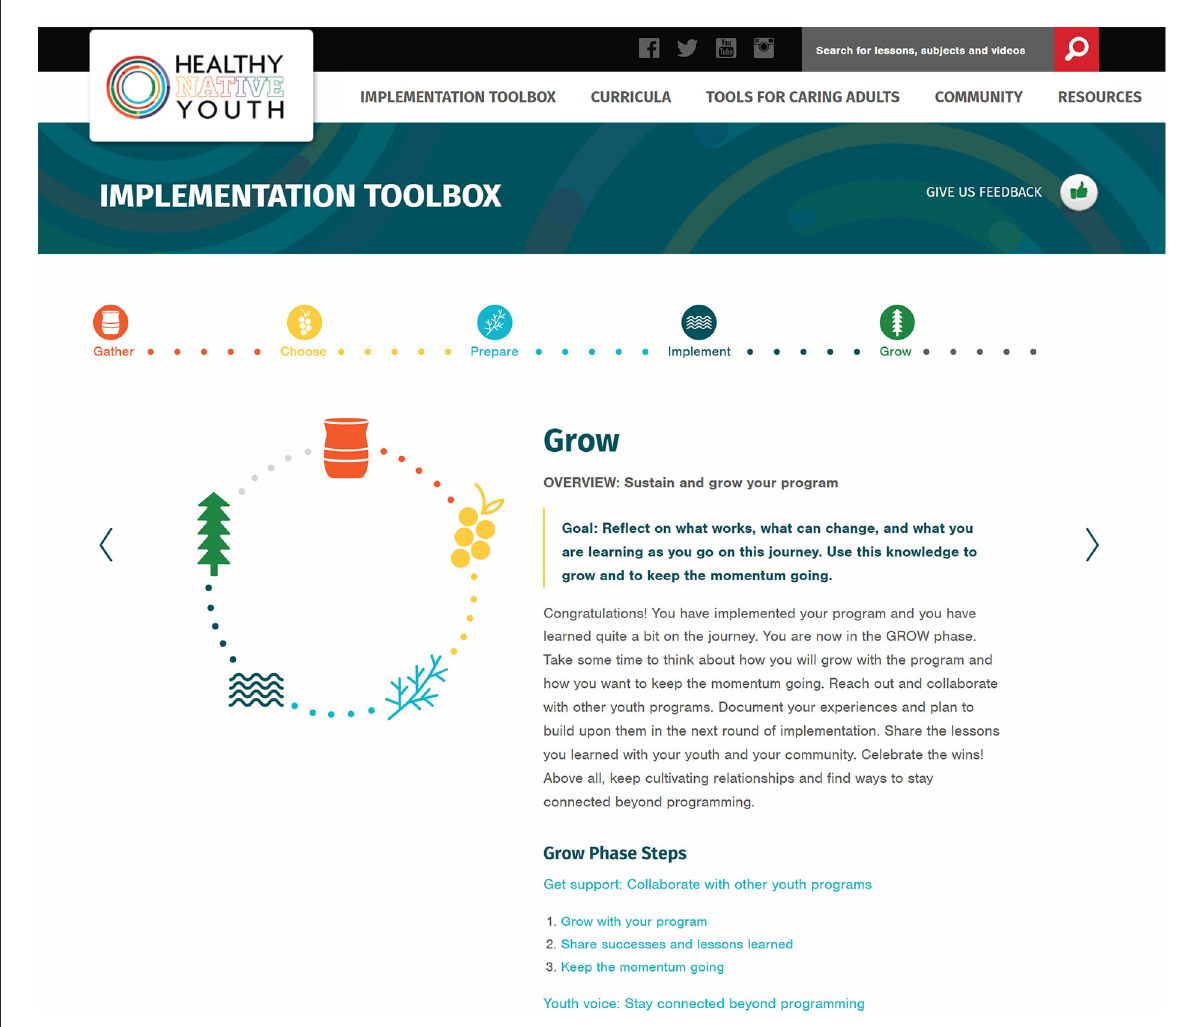
FIGURE7 Screen capture of the Healthy Native Youth Implementation Toolbox : GROW phase overview.